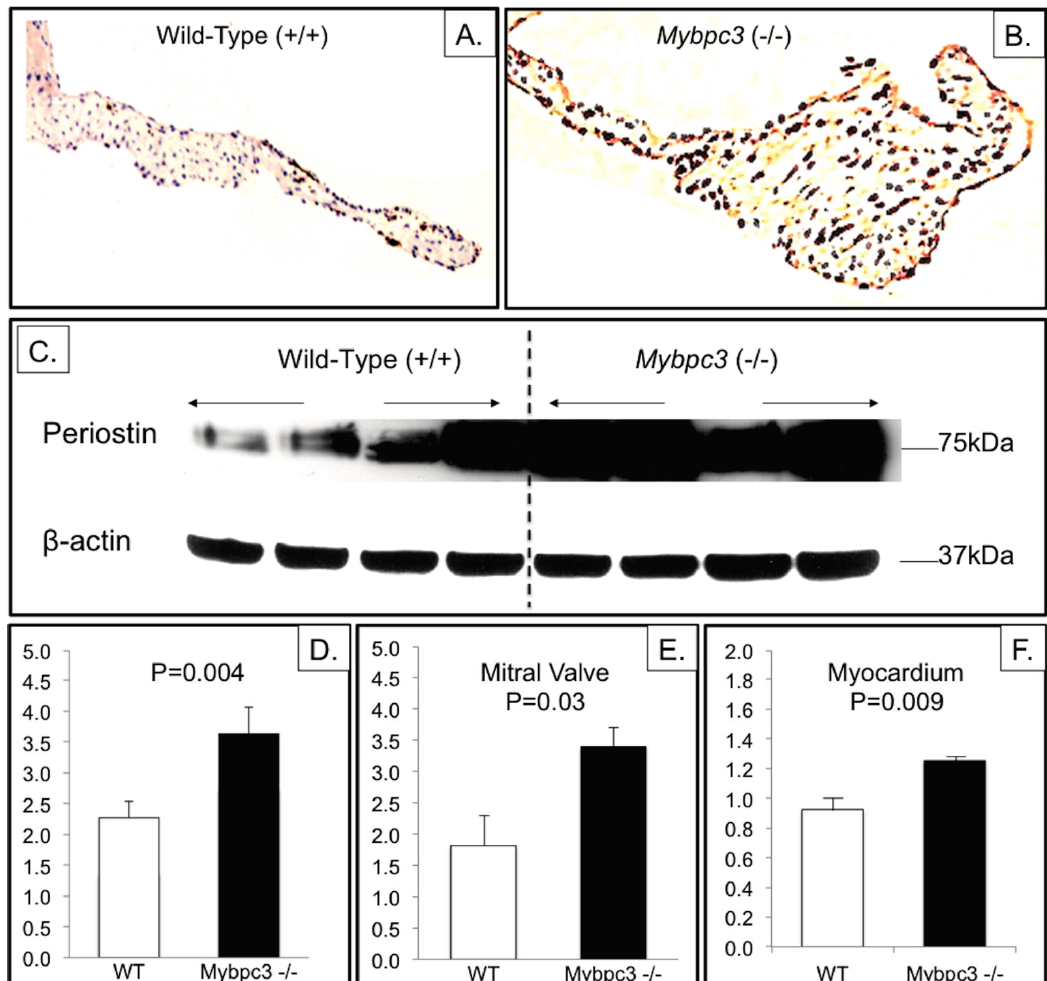
Figure 3. Mybpc3 ( − / − ) MVs have increased periostin. Immunostaining for periostin was performed using DAB as the chromogen (brown). Representative low power (40×, A , B ) images are shown from (+/+) ( A ) and Mybpc3 ( − / − ) ( B ) mice. Increased periostin (brown) is evident in the Mybpc3 ( − / − ) MV leaflets; ( C ) Western blot for quantification of periostin in MV leaflets comparing 4 (+/+) and 4 ( − / − ) leaflets, with use of β -actin to normalize for protein loading. Relative quantification of immunostaining ( D ) was performed by blinded reviewers using a scale from 1 (faint staining) to 5 (strong staining). Quantification of Western blots was performed by NIH ImageJ software, demonstrating increased periostin in both MV leaflets ( E ) and adjacent myocardium ( F ) in Mybpc3 ( − / − ) mice compared to wild- type controls (+/+). Error bars show